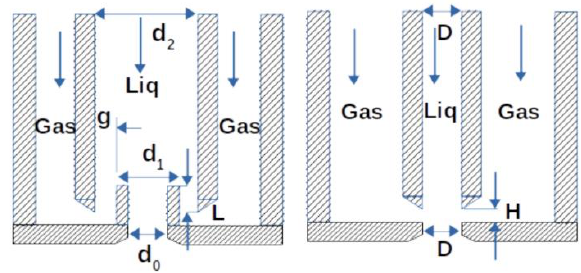
Figure 2. Left - CF atomizer as tested in [2], right – FB atomizer .